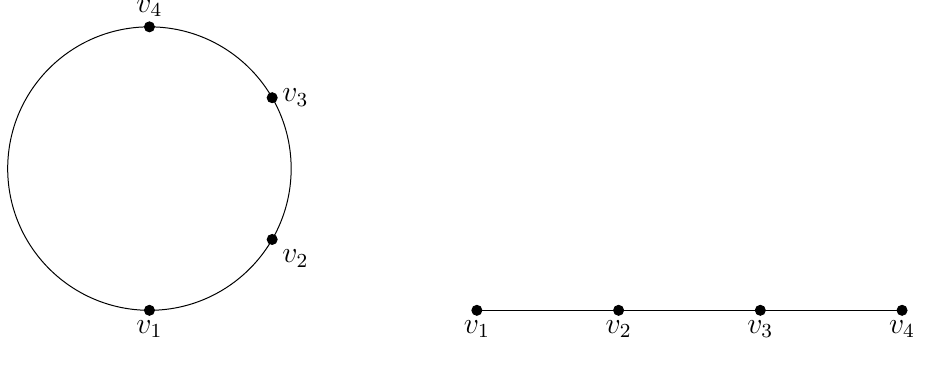
Figure 3: Two isometric metrizations of C ( w ) satisfying equality